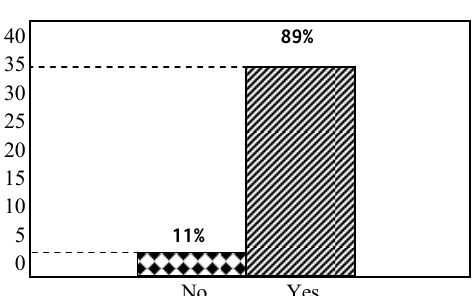
Figure 2: Apparel; books, magazines and stationary;